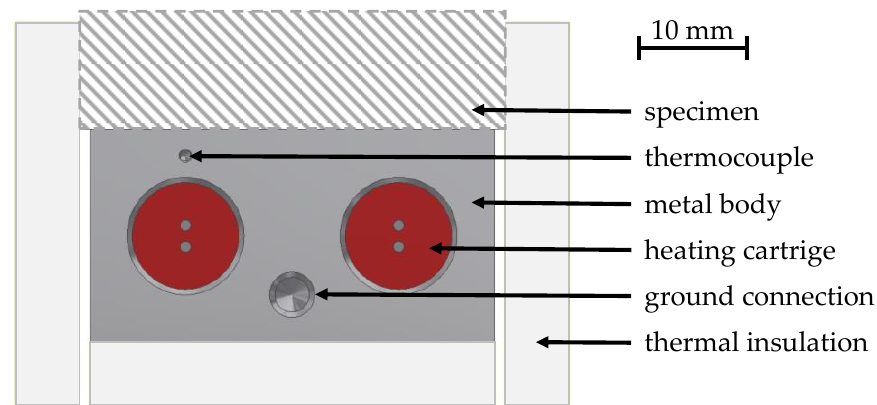
Figure 4. Components of the heating device. Table 1. Experimental